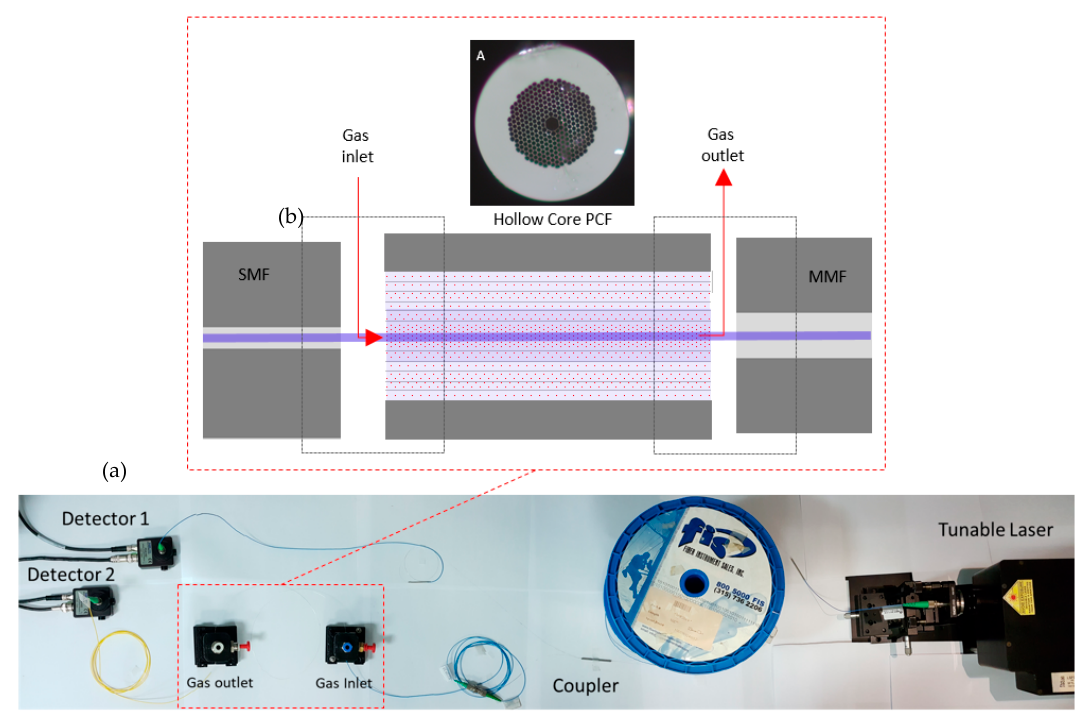
Figure 4. ( a ) Photograph of the complete sensor setup; ( b ) schematic representation of the injection and extraction points for gas and light from the sensing HC-PCF. In detail, the cross section of the HC-PCF used.